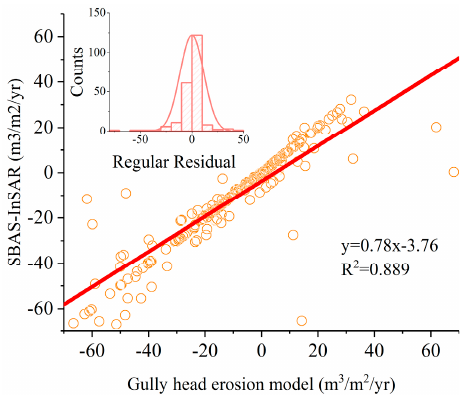
Figure 18. GHER measurements from the SBAS-InSAR and gully head erosion